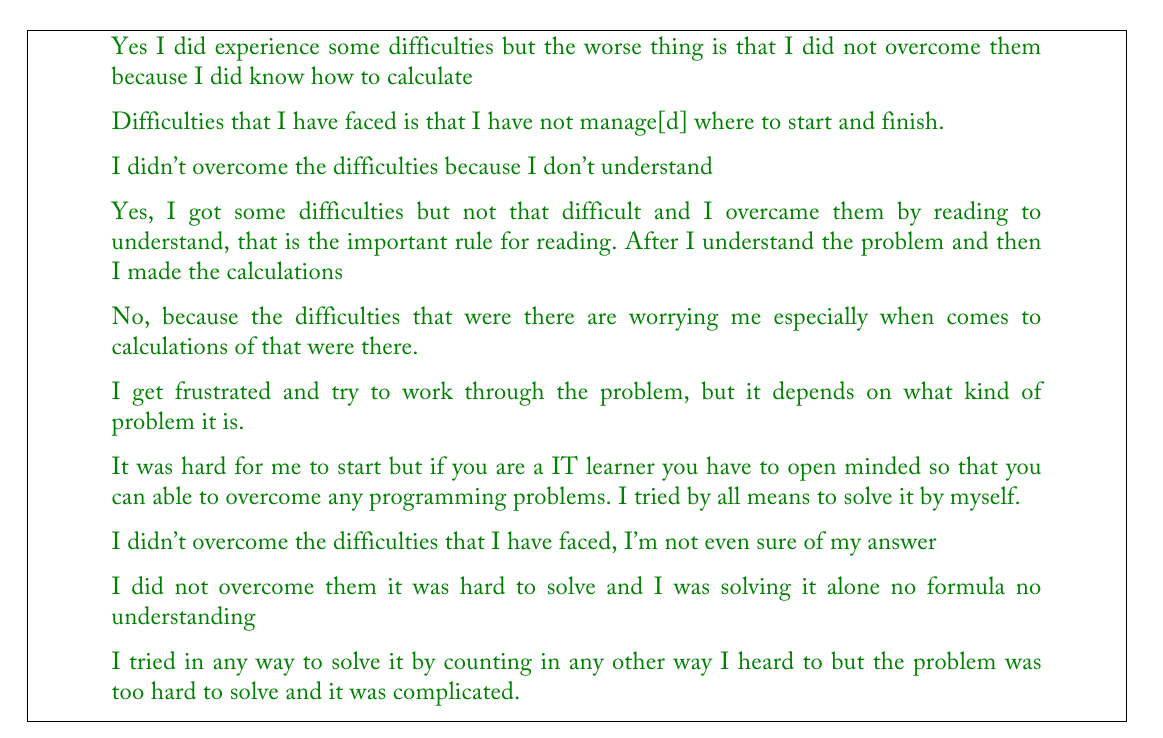
Table 2: Examples of student responses prior to learning the problem solving steps